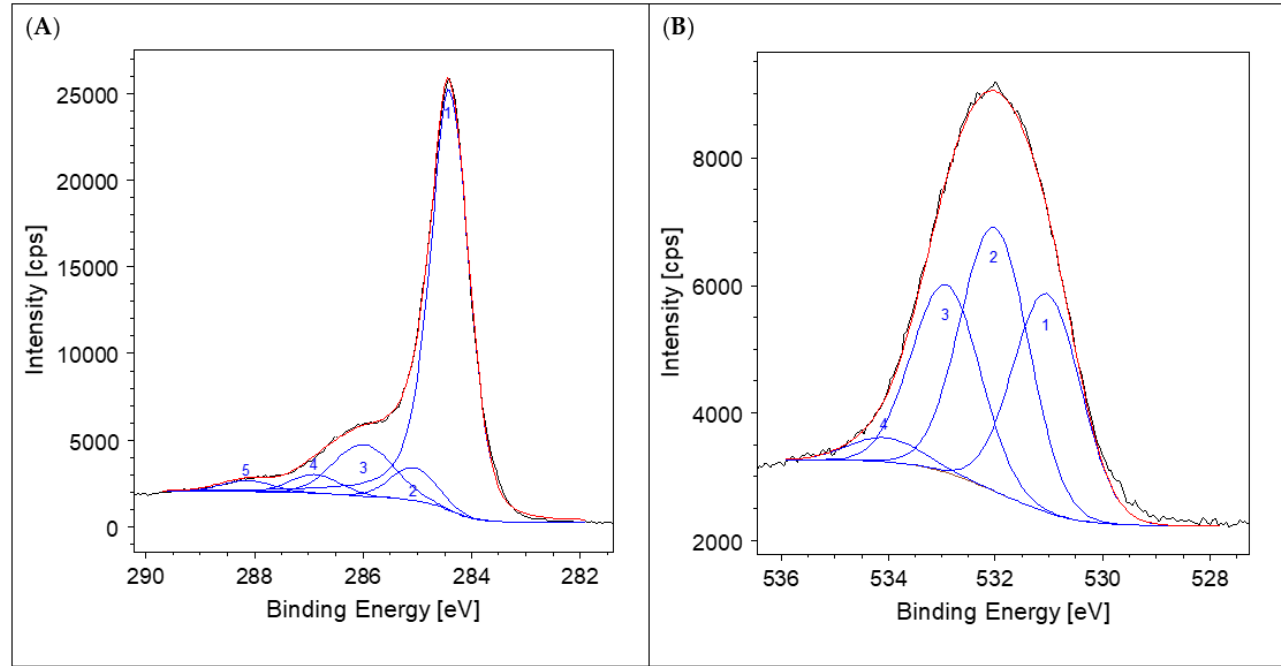
Figure 3. ( A ) C 1s and ( B ) O 1s core-lines of the S_N3 sample reported together with their peak fitting.